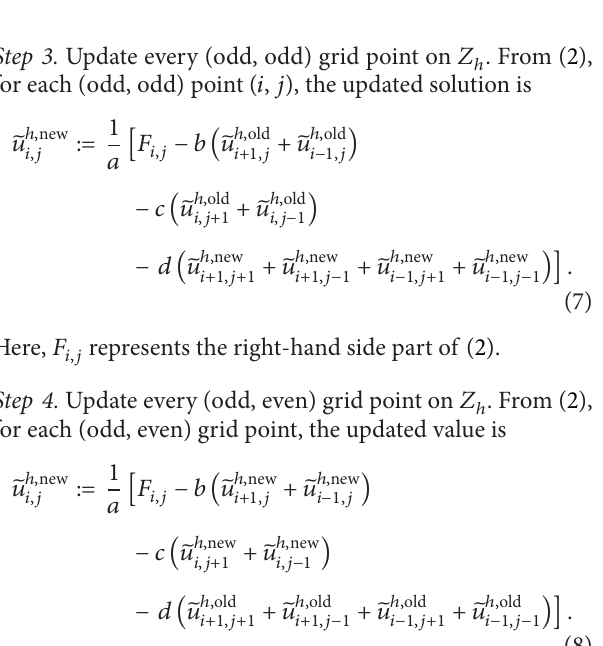
Figure 1: Four types of points on 4 × 4